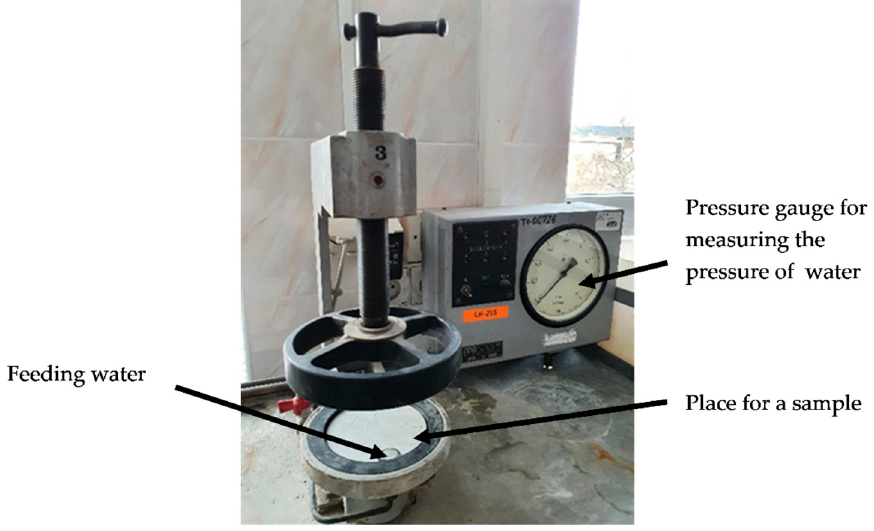
Figure 1. Equipment for testing water absorption of coatings.